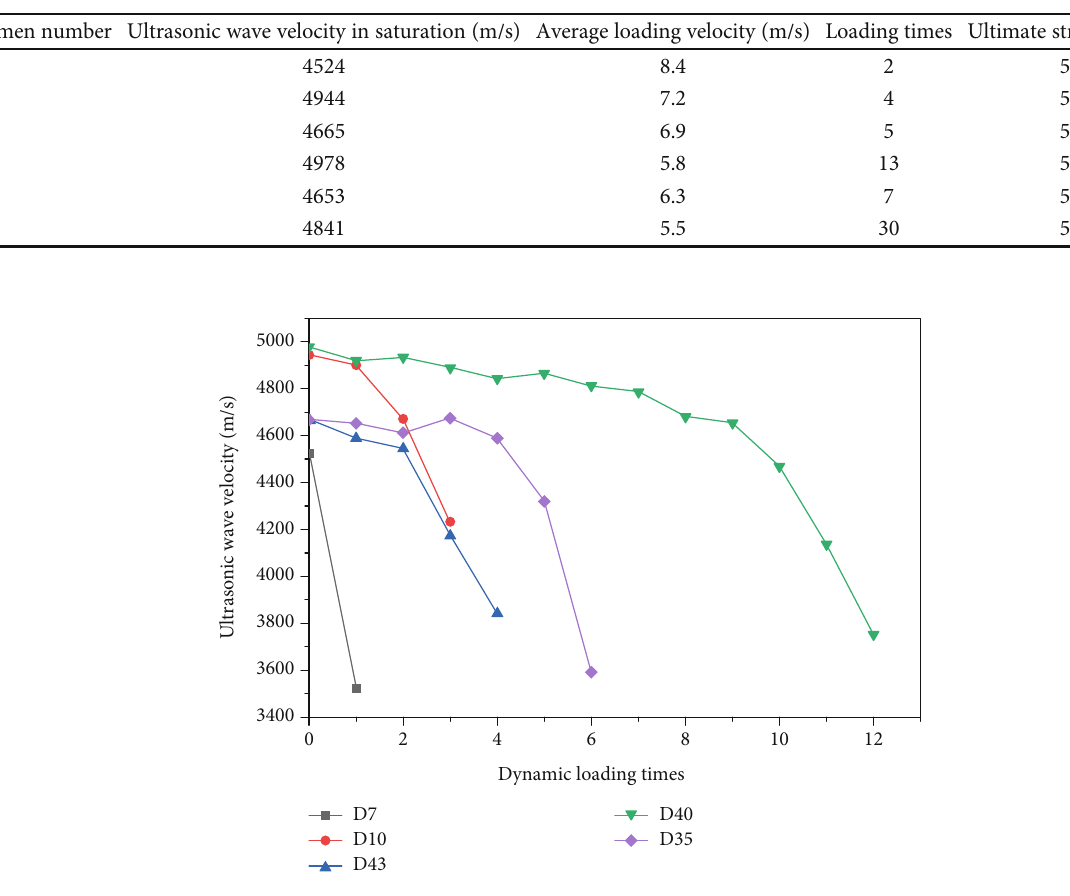
Table 3: Constant-velocity cyclic dynamic loading test.